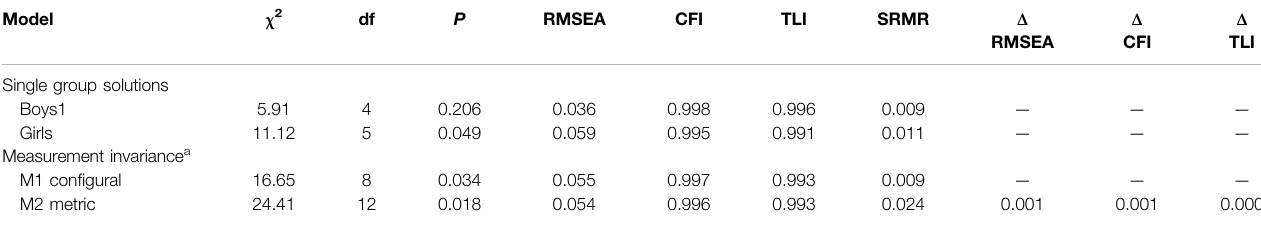
TABLE 4 | Tests for measurement invariance for function words factor across boys and girls.